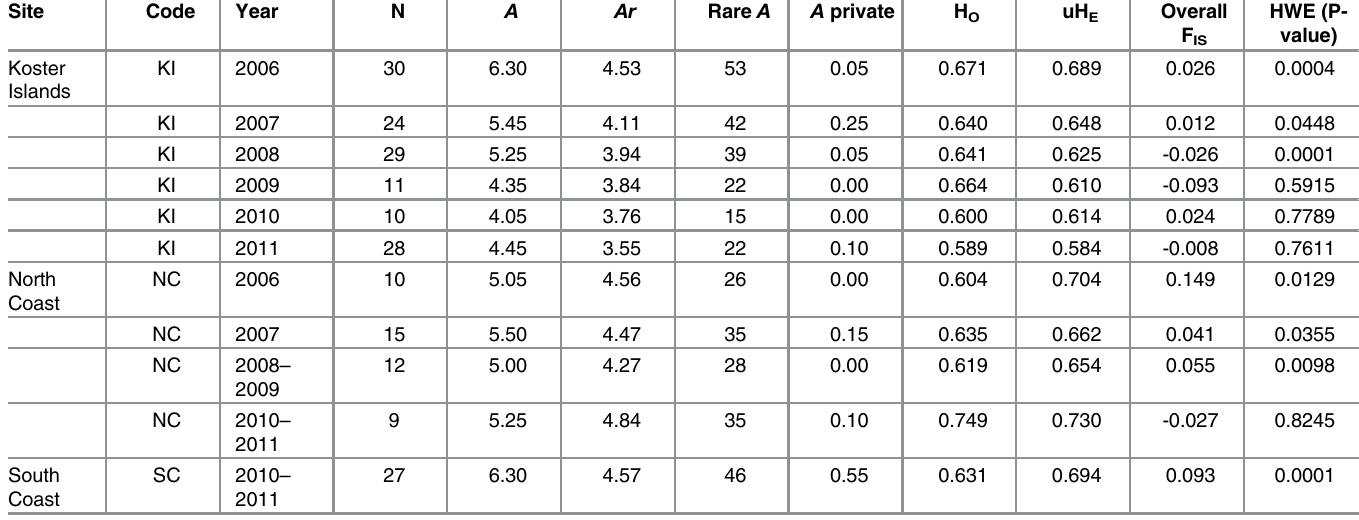
Table 1. Genetic diversity indices of American mink from three sites in Sweden collected in consecutive years 2006 – 2011. N – number of analysed samples; A – mean number of alleles per locus (direct count); Ar – allelic richness estimated by rarefaction based on a minimum sample size n = 7; Rare A – number of alleles with frequency (cid:3) 0,07 across all loci; A private – private alleles, H O − observed heterozygosity; uH E − unbiased expected heterozygosity. Year reflects the hunting season (e.g. 2006 indicates the hunting season of 2006/2007). P value after Bonferroni correction